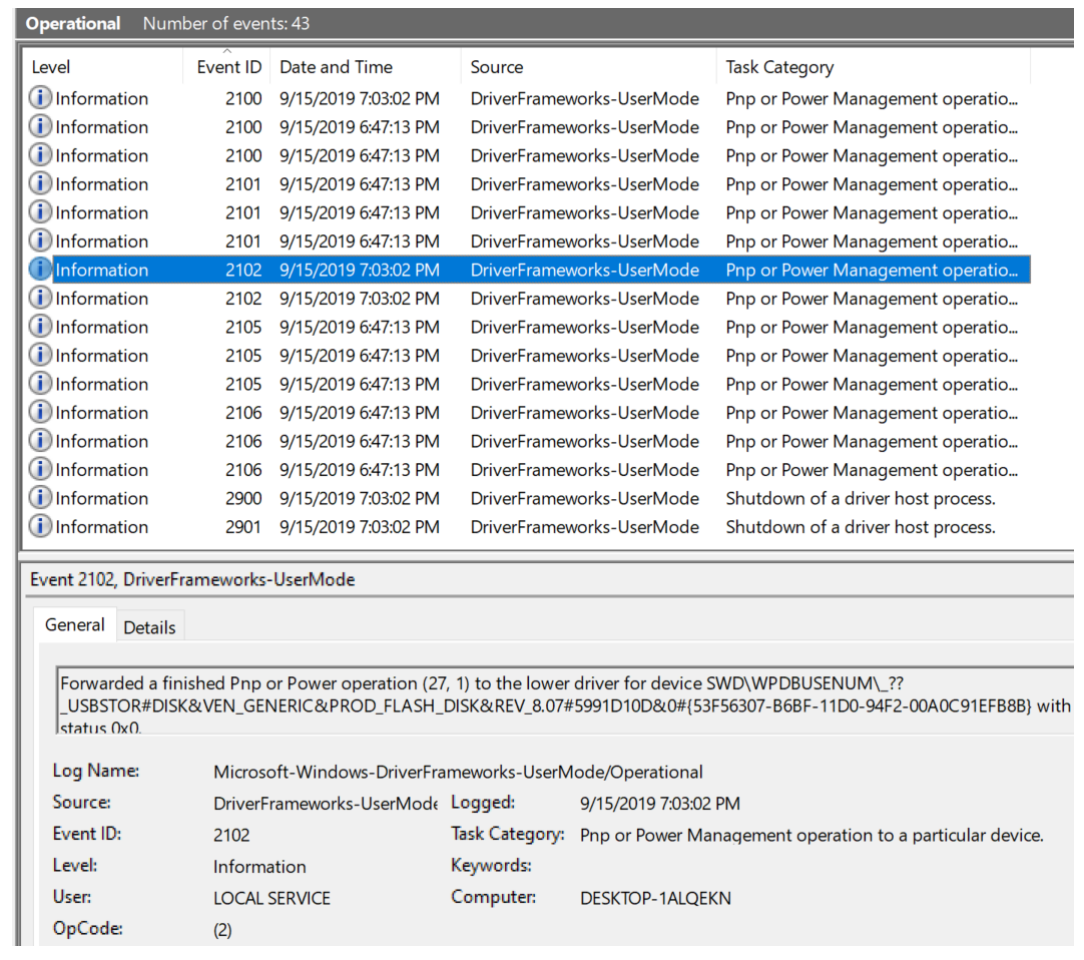
Figure 6. Event ID 2102 in Windows Event